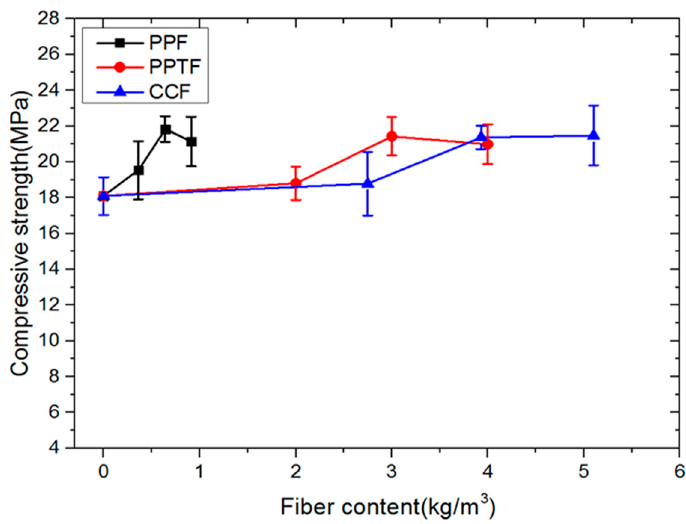
Figure 8. Influence of fiber types and content on compressive strength.